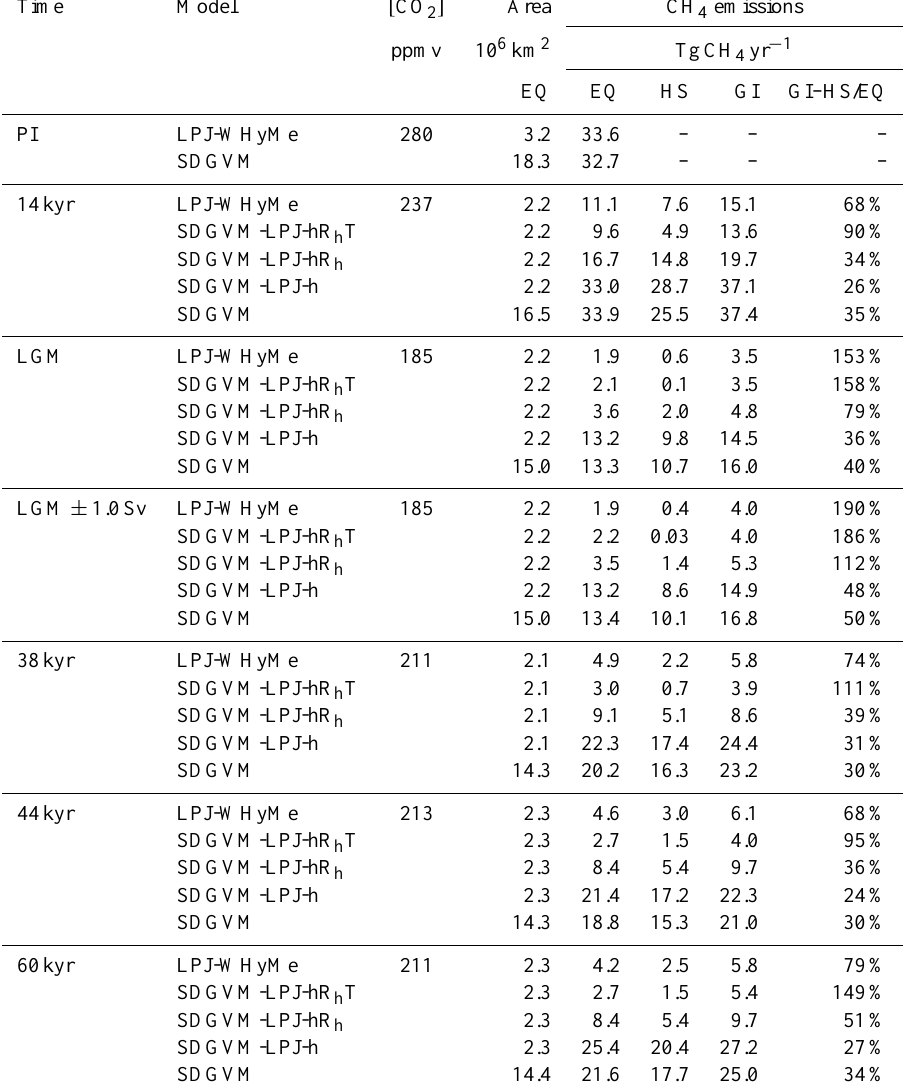
Table 4. CH 4 emissions in sensitivity simulations with modified model versions and ≥ 45 ◦ N in SDGVM (this study and Hopcroft et al., 2011). h , R h and T signify hydrology, soil heterotrophic respiration and soil temperature respectively. These fields are read into the modified versions of SDGVM from LPJ-WHyMe. Wetland area in SDGVM is calculated from the area with the water table depth ≥ 0cm, but in other models is the area of prescribed